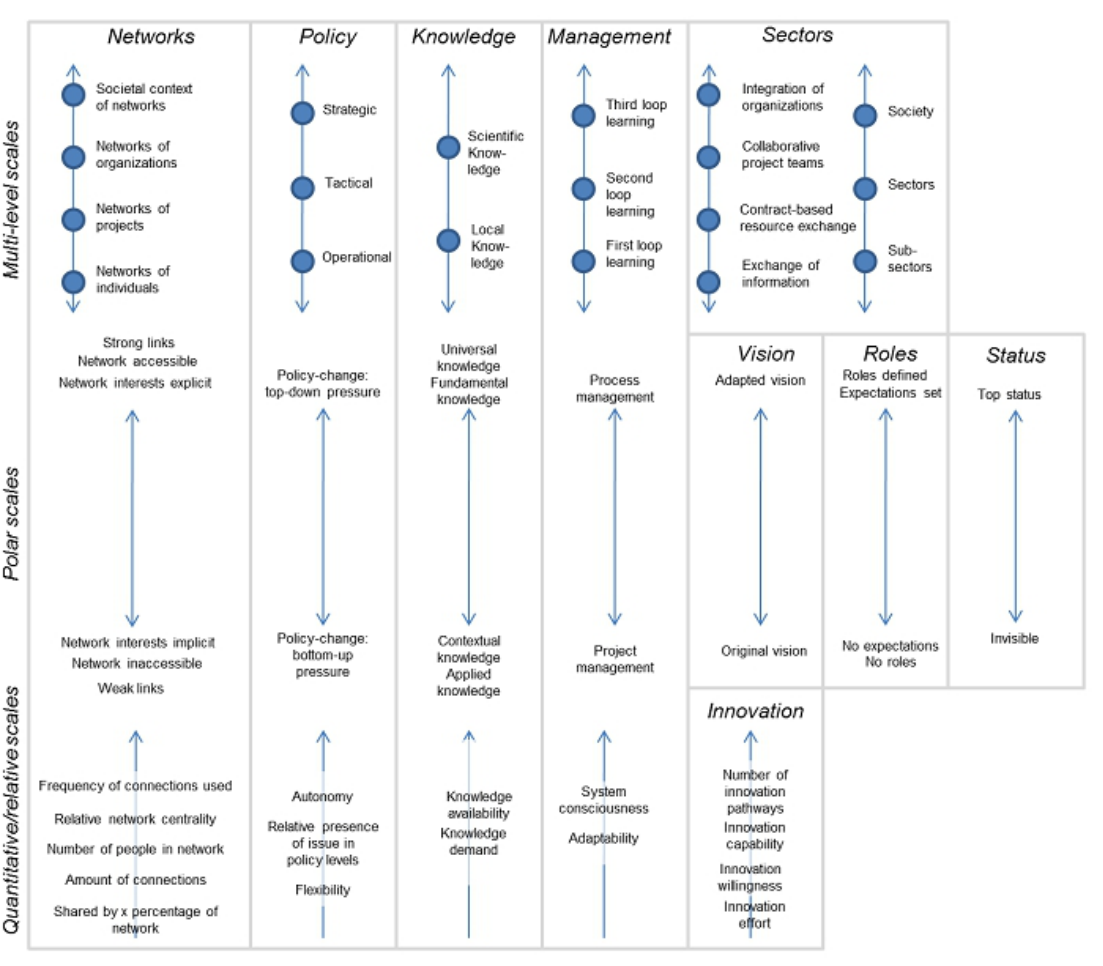
Fig. 4 . Scales produced by participants using the scale